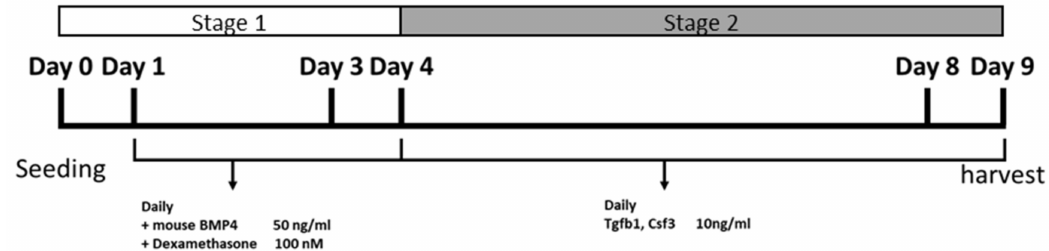
Figure 1. Overview of the two stage chondrogenic differentiation protocol. In the first stage, through Bmp4 and dexametha- sone stimulation, the iPS cells were first differentiated into mesodermal cells. In the second stage, these cells were further treated with Tgfb1 and/or Csf3 for 5 days, to induce chondrogenic differentiation. At the end of each stage, samples were collected for examination.